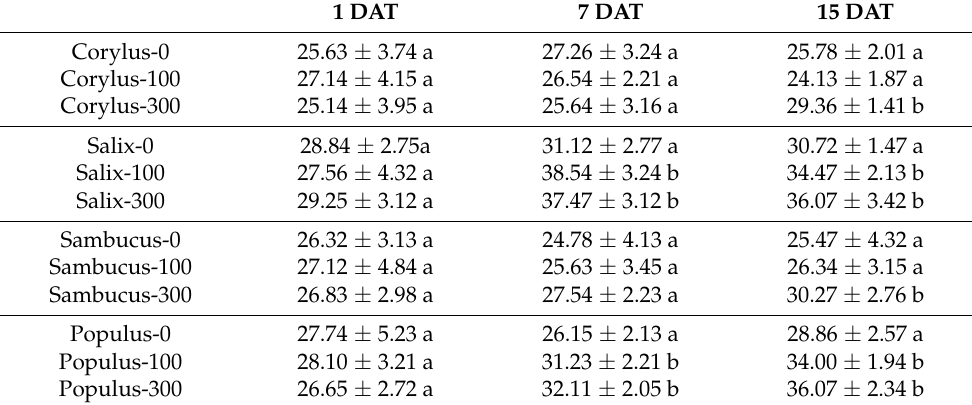
Table 2. Chlorophyll content (expressed as SPAD measurements) of the leaves of Corylus , Salix , Sambucus , and Populus grown treated with the three NO 3 − concentrations in hydroponic nutrient solution at 1, 7, and 15 days after the treatment